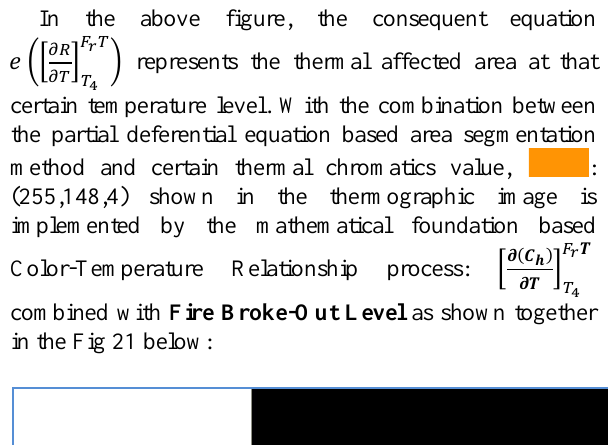
Figure 20. Temperature affected area at the fire ignition level